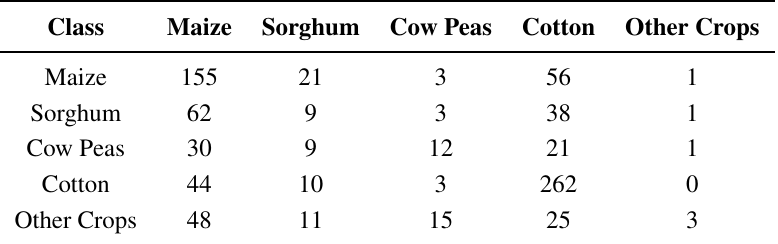
Table 7. Confusion matrix for RF on the Burkina test site.